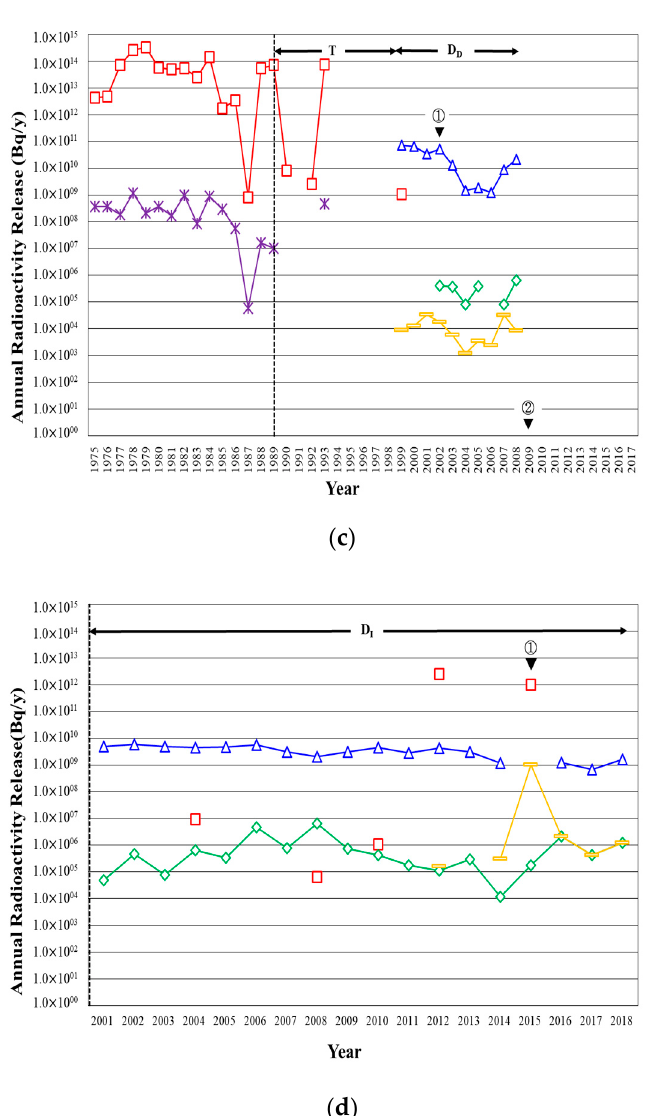
Figure 5. Annual radioactivity release of airborne effluent before and after permanent shutdown of NPPs: (a) Crystal River-3; (b) Kewaunee; (c) Rancho Seco; (d) Trino. The number ① indicates the year of shipment of SF and ② indicates the license termination year. T, D D and D I represent decommissioning phases depicted in Figure 2. The dotted line indicates the year of permanent shutdown.